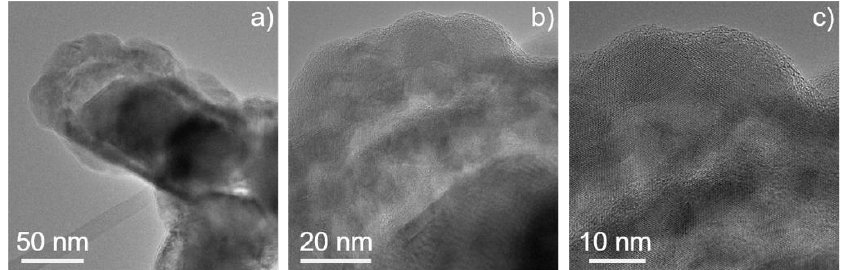
Figure 4. ( a ) Lower magnification and ( b , c ) higher magnification HRTEM images acquired from